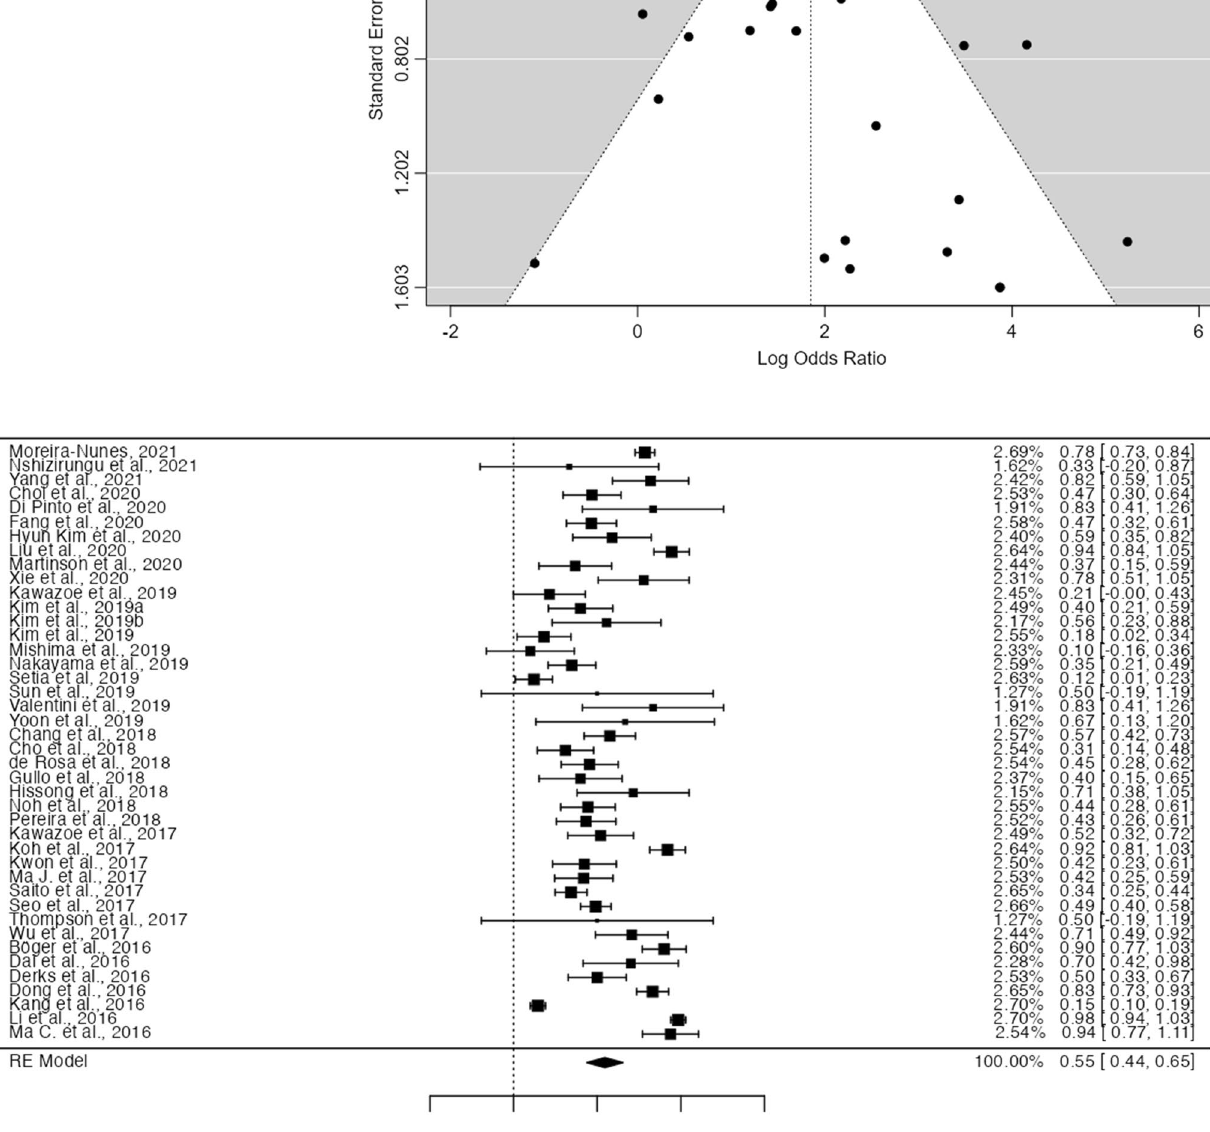
Fig. 4 Forest-plot describing the proportion of PD-L1 positivity in EBV positive